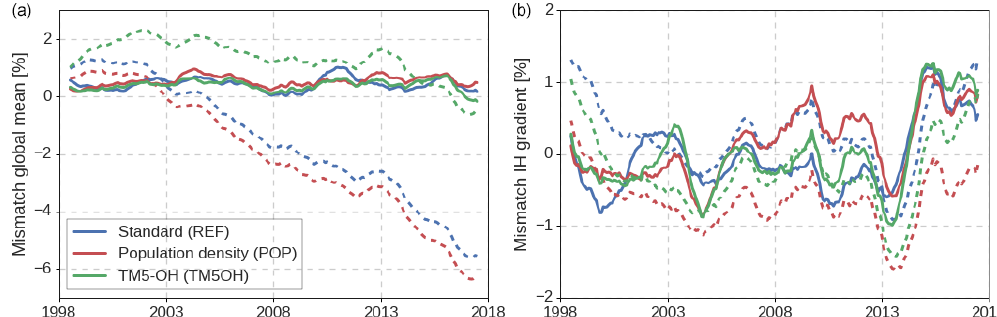
Figure 4. Fractional mismatch between simulated and observed MCF mole fractions in the global mean (a) and the interhemispheric gra- dient (b) . Mismatches are given relative to global mean MCF and averaged using a 12-month running mean. Dashed lines indicate prior mismatches, while solid lines show posterior mismatches. Global and hemispheric mean mole fractions were calculated from the NOAA surface network following the methods outlined in S1 of Naus et al. (2019).